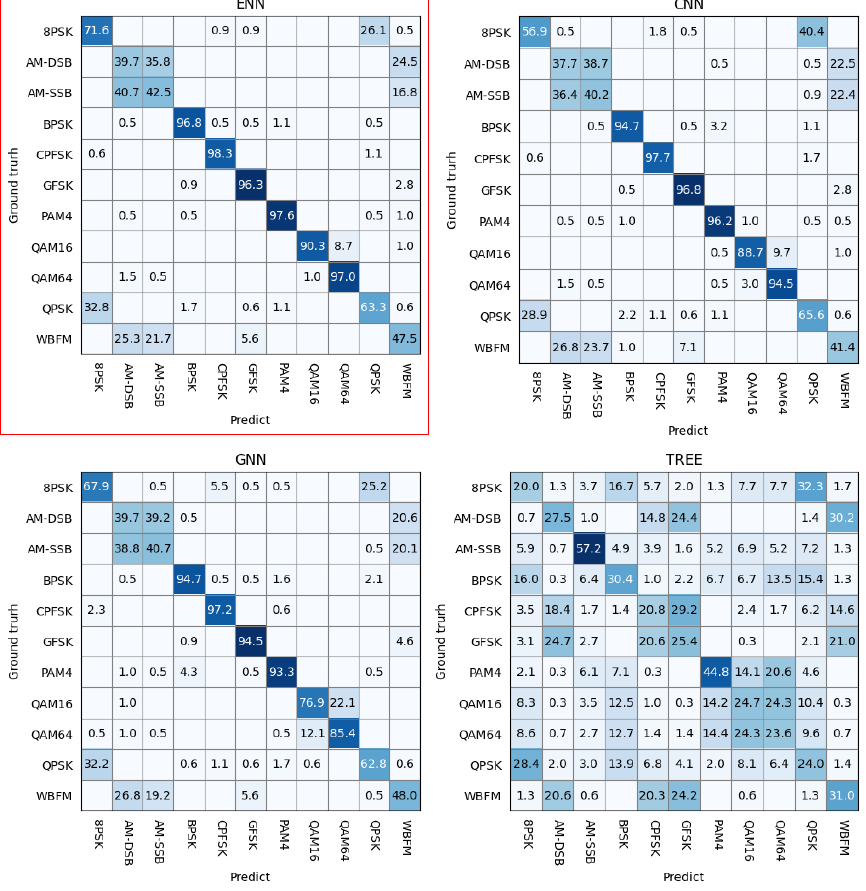
Figure 7. Confusion matrices of the proposed method and the comparison methods at SNR of 6 dB. The confusion matrix of our model has been highlighted with a red square. The stronger the blue color, the higher the classification accuracy. Table 3. Experimental results of the indicators at various SNRs. Experimental results of our model are